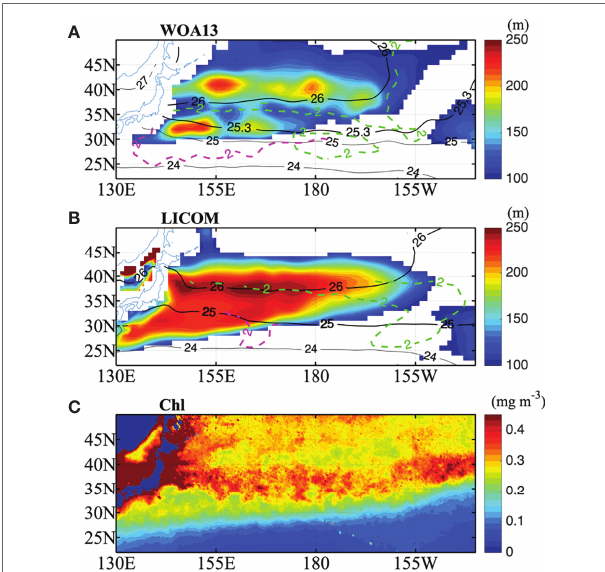
FIGURE 1 | (A) March climatology of the mixed layer depth larger than 100 m (shaded) and the density at the surface (black solid line) for WOA13 along with the PV= 2.0×10 -10 m -1 s -1 on 25.3 σ (magenta dashed) and 26 θ σ θ (green dashed), bold solid black contour shows surface density at 25.3 σ θ and 26 σ . (B) is the same as (A) but for LICOM except dashed contour for θ PV= 2.0×10 -10 m -1 s -1 on 25 σ and 26 σ , and bold solid contour for surface θ θ density at 25 σ and 26 σ . The lighter low PV layer (megenta dashed) θ θ corresponds to the core layer of the STMW, while the denser layer (green dashed) corresponds to the core layer of the CMW. (C) March climatology of chlorophyll concentration in mg m -3 . The chlorophyll data is satellite-retrieved from the Sea-viewing Wide Field-of-view Sensor (SeaWiFS) covering the period from September 1997 to December